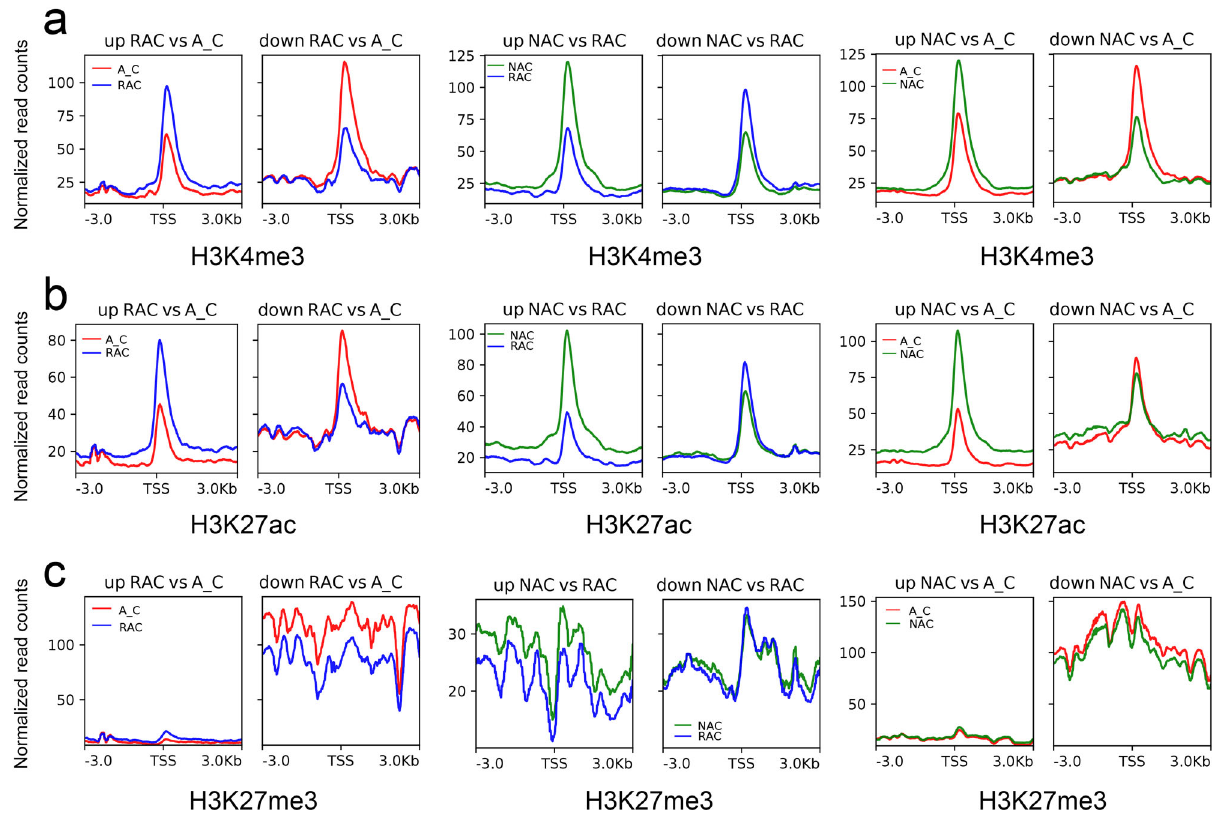
Fig. 6 The relationship between DEGs and three histone modi fi cations. a The relationship between DEGs and H3K4me3. b The relationship between DEGs and H3K27ac. c The relationship between DEGs and H3K27me3. DEGs, differentially expressed genes; A_C, in silico ‘ hybrid ’ ; RAC, resynthesized B. napus ; NAC, natural B. napus ; TSS, transcriptional start